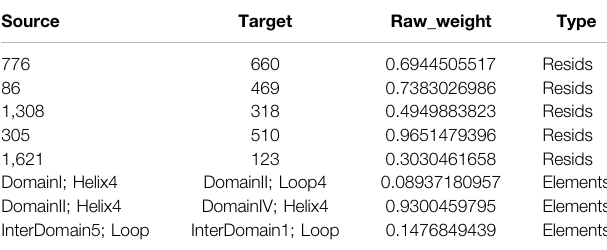
TABLE 2 | Relationship table example. Four columns are allowed with the following headers: “ source ” , “ target ” , “ raw_weight ” , and “ type ” . First and secondcolumnsindicatingtheinteractingresiduesorelements.The “ raw_weight ” column contains an edge weight for color or width mapping. The last column “ type ” can be used to indicate edge types which can be weighted or colored separately.